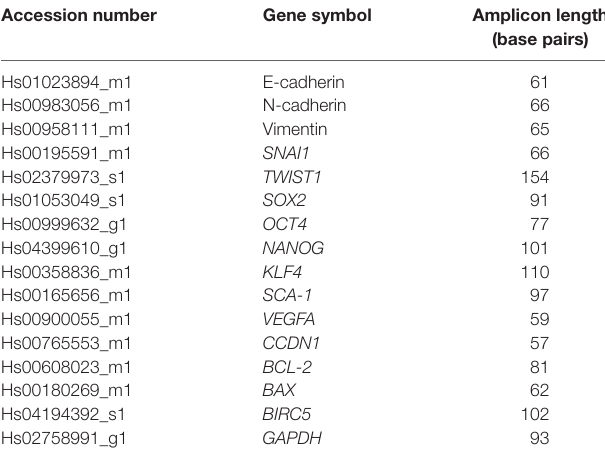
TaBle 2 | List of Taqman ® gene expression